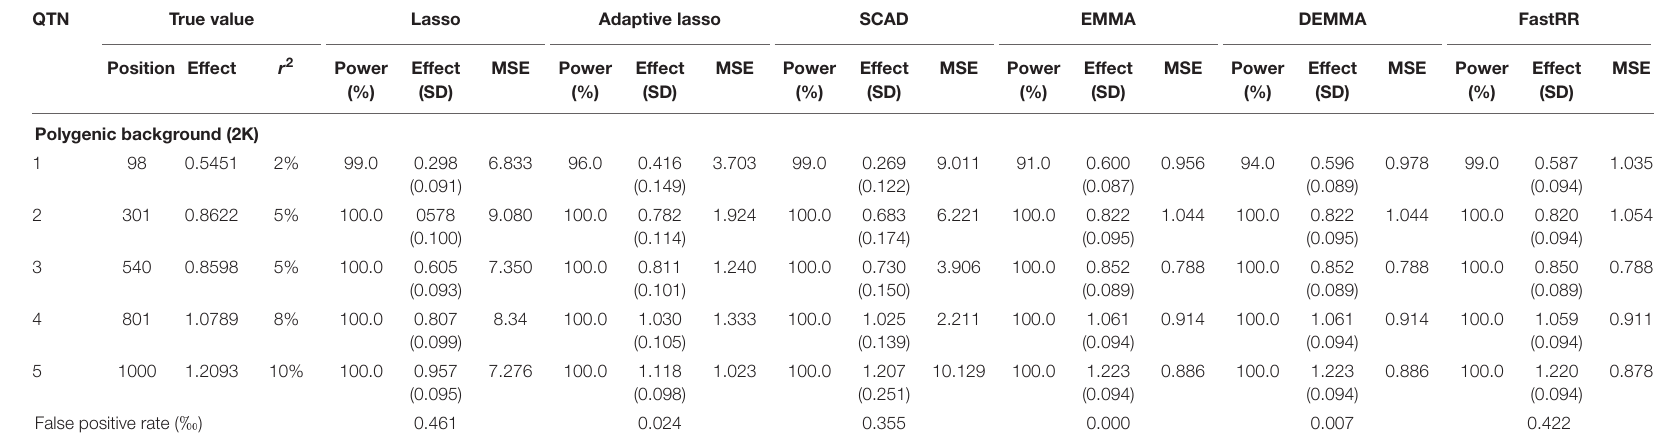
TABLE 2A | Comparison of lasso, adaptive lasso, SCAD, EMMA, DEMMA, and FastRR methods in the second simulation experiment (scenarios 1: two times polygenic background). QTN True value Lasso Adaptive lasso SCAD EMMA DEMMA FastRR